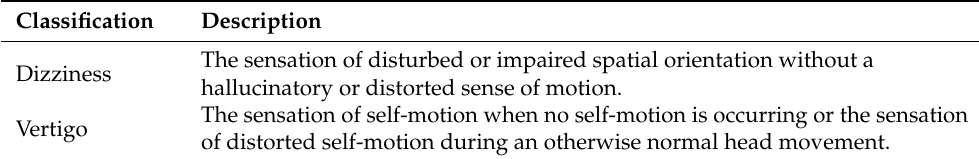
Table 2. Definition of dizziness and vertigo by the International B á r á ny Society for